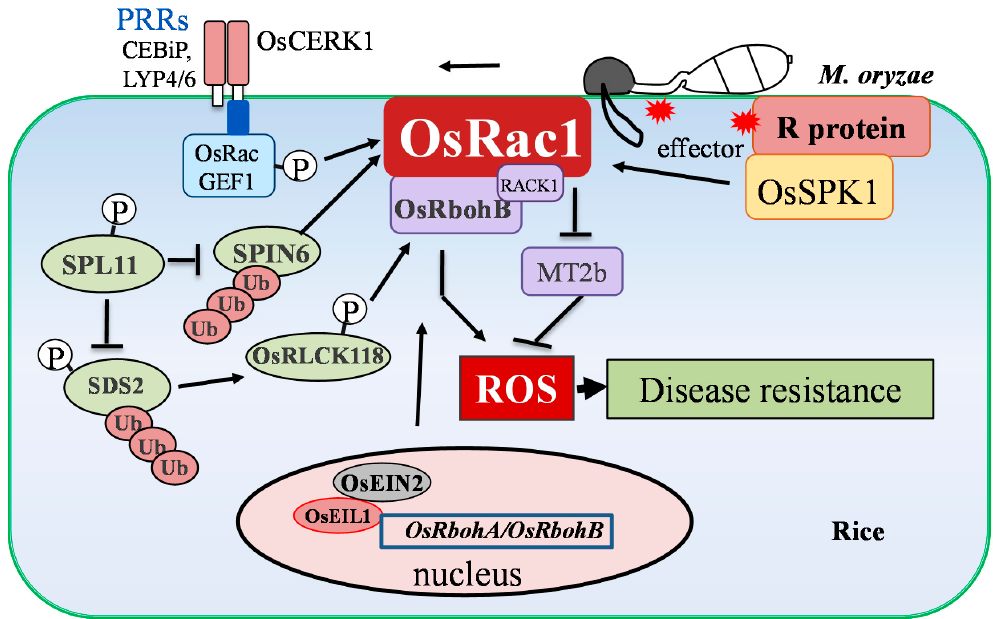
Figure 3. OsRbohB as an important component against rice blast. Small GTPase, OsRac1, can be activated by both pathogen-associated molecular patterns (PAMPs) triggered immunity (PTI) and effector-triggered immunity (ETI) to induce OsRbohB-dependent ROS production and suppress ROS scavenging. By sensing the PAMPs or effectors, the OsRac1 is activated to induce ROS accumulation